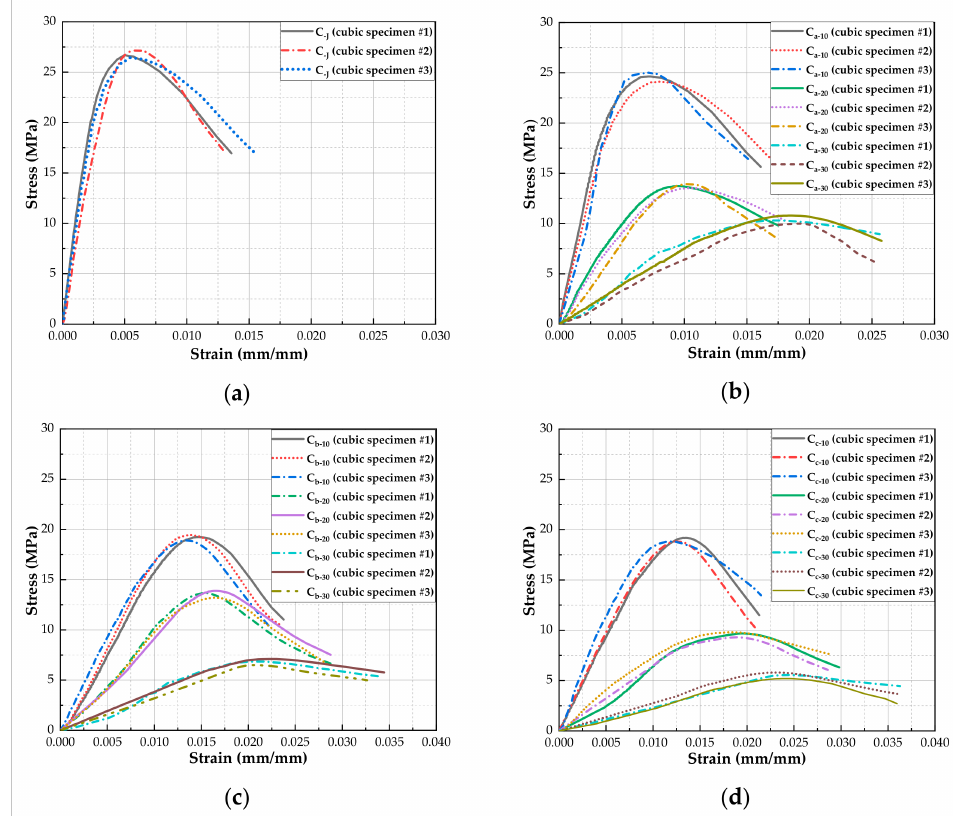
Figure 8. Stress-strain curves of cubic specimens: ( a ) Control group, ( b ) particle size 3~5 mm, ( c ) particle size 1~3 mm, and ( d ) particle size 40